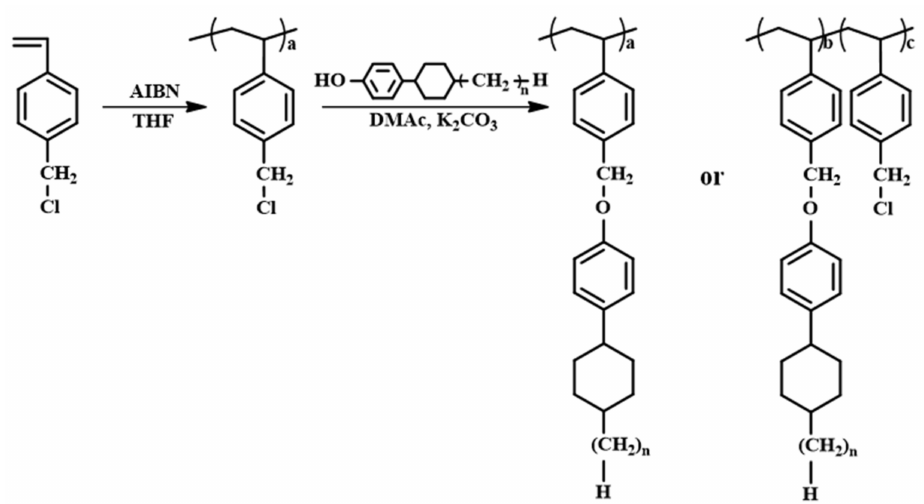
Figure 1. Synthetic route to 4-( trans -4-ethylcyclohexyl)phenoxymethyl (PECH# and PECH, n = 2), 4-( trans -4- propylcyclohexyl)phenoxymethyl (PPCH, n = 3), 4-( trans -4-butylcyclohexyl)phenoxymethyl (PBCH, n = 4), and 4-( trans - 4-amylcyclohexyl)phenoxymethyl-substituted polystyrene (PAmCH, n = 5), where # represents the molar fraction of 4-( trans -4- ethylcyclohexyl)phenol containing monomeric units in the